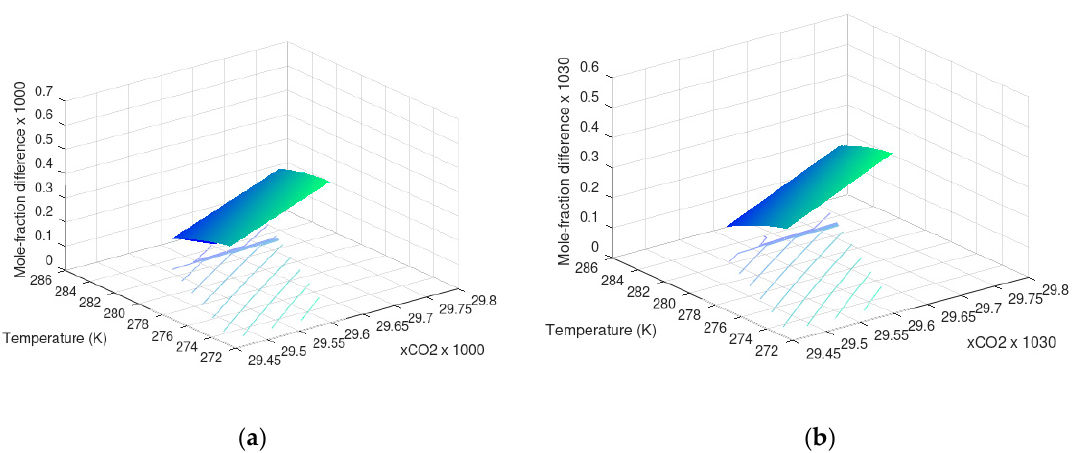
Figure 15. Hydrate growth potential in terms of mole-fraction, from solubility down to hydrate stability limit ( z -axis), as function of solubility mole-fraction ( x -axis) and temperature ( y -axis) and pressure. For each temperature on the temperature axis, solubilities and growth potentials are calculated for pressures from 90 bar to 300 bar This is reflected in the increased solubility along the x -axis. ( a ) Pure water and ( b ) 3 mole% ethanol in water.